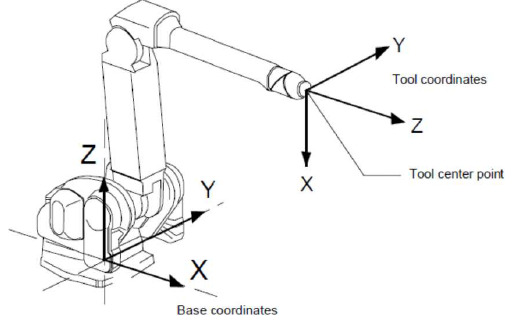
Figure 1: General structure of a robotic